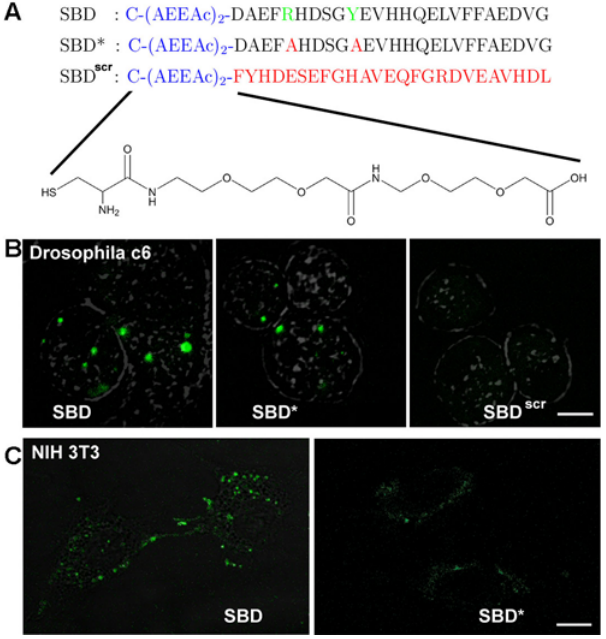
Figure 1. SBD binds to and is internalized by insect and mammalian cells. A. Sequences of the SBD, SBD*, and SBD scr peptides with amino-terminal Cysteine and AEEAc spacer. For SBD-TMR, the fluorophore was conjugated directly via amine linkage to the spacer. B. Drosophila c6 neuronal cells labelled with SBD-, SBD*-, or SBD scr -Oregon Green (conjugated with SBD at the terminal Cysteine) at 10 uM in HBSS for 15 min at 25 u C. Wild type SBD shows internalized punctae representative of endocytic domains, whereas the number and intensity of punctae in SBD* and SBD scr are much reduced. C. Mouse NIH3T3 fibroblasts labelled with SBD-OG or SBD*-OG at 2 m M in HBSS for 15 min at 37 u C. Scalebar in B=5 m m; in C=10 m m.